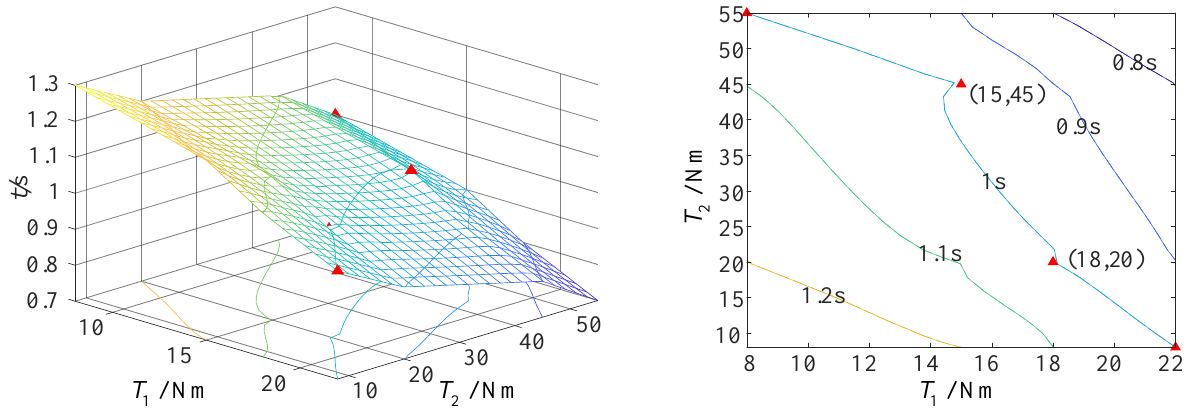
Figure 24. The curve of driving torque and deployment time of folding wing at an airspeed of 40 m/s (fixed-axis – non-fixed-axis stepwise deployment mode).